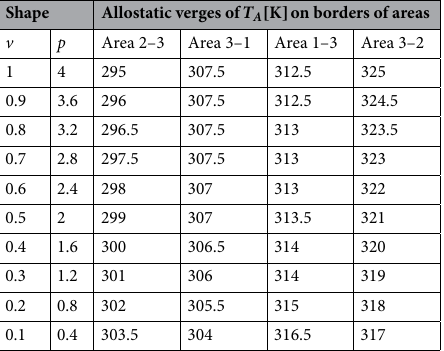
Shape Allostatic verges of T A [ K ] on borders of areas